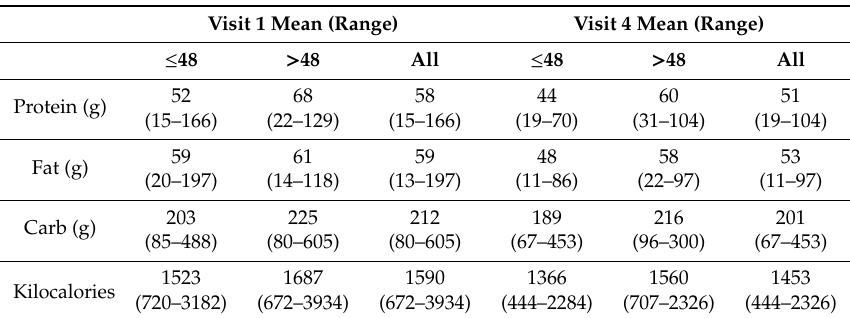
Table 3. Kilocalorie and macronutrient intake by age group.